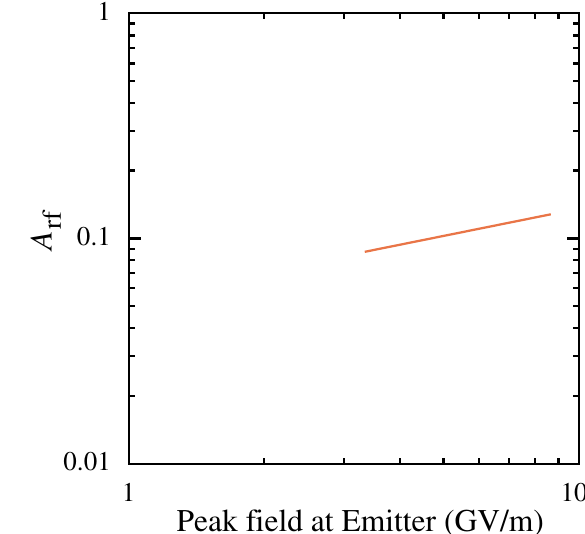
FIG. 33. (Color) Dependence of exponent, n on the peak field at the emitter.